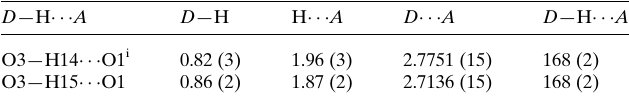
Table 1 Hydrogen-bond geometry (A˚ , (cid:4) ).